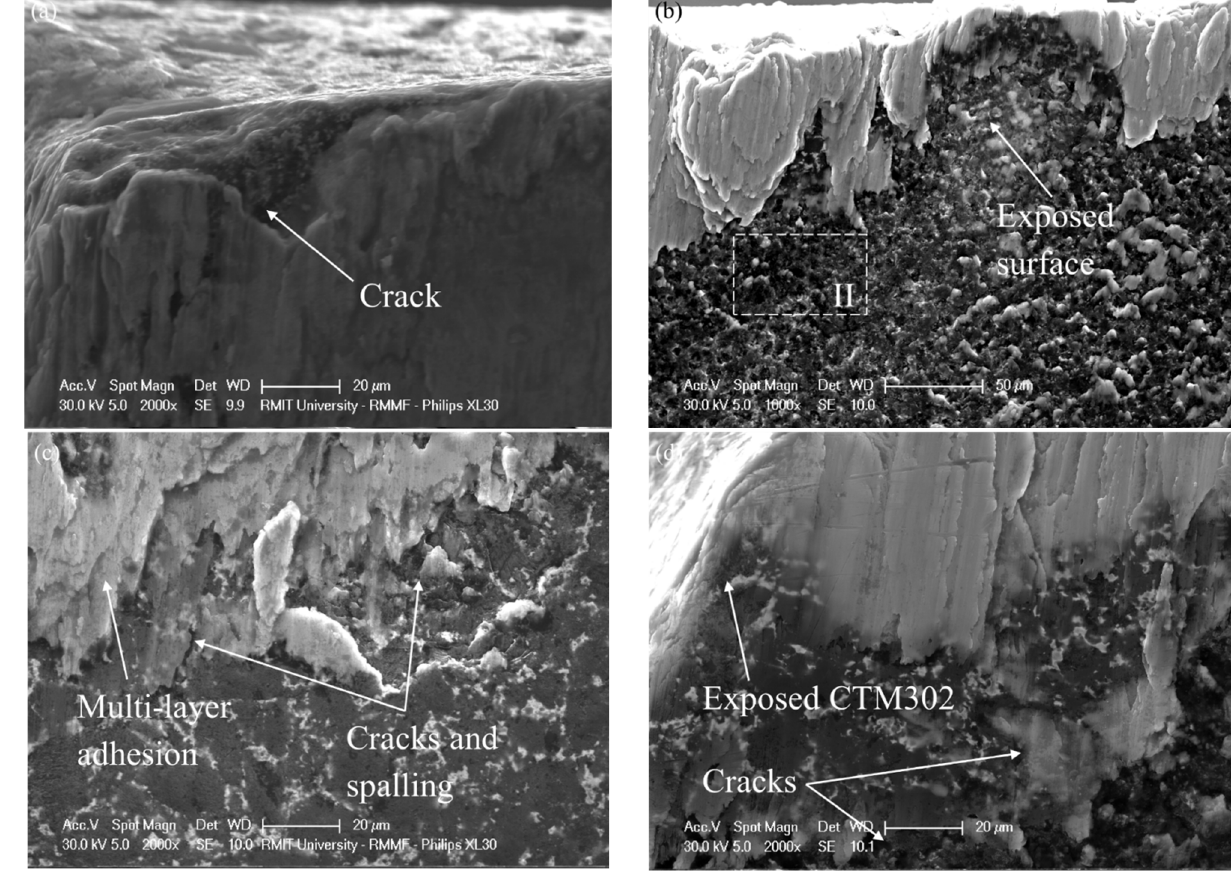
Figure 10. Micro-morphology of the regions I on the worn surface of different PCD tools: ( a ) 002A, ( b ) 002E, ( c ) 302A, and ( d ) 302E.